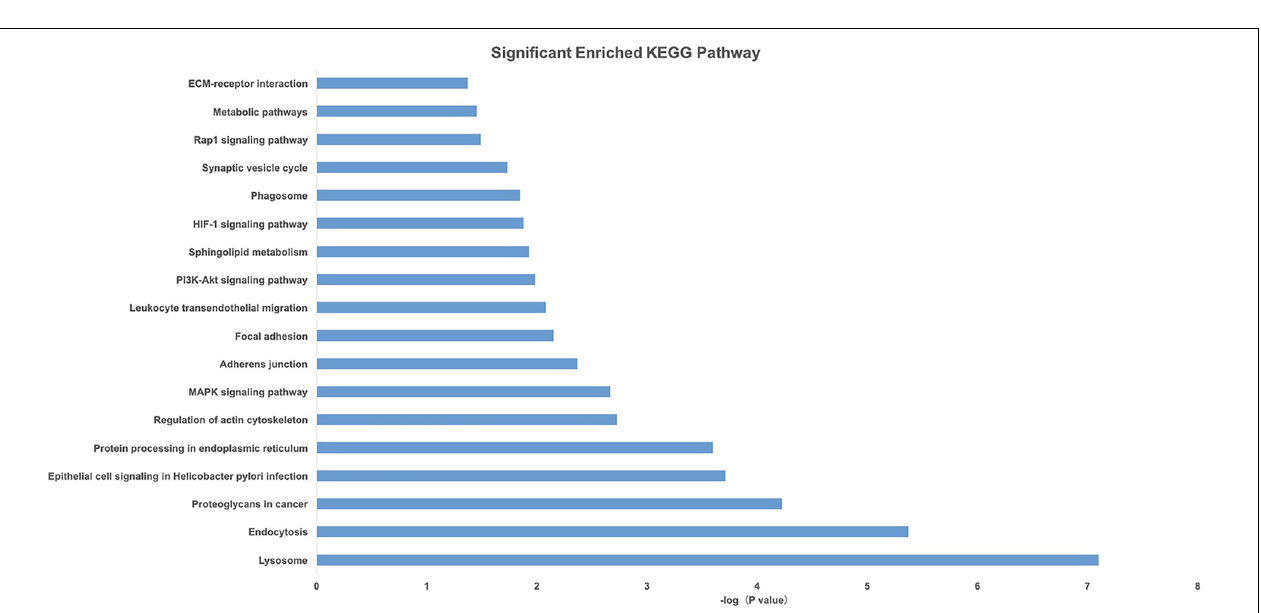
FIGURE 4 | Gene Ontology (GO) analysis of candidate genes. –Log10( p -value) of the corresponding biological process (BP), molecular function (MF), and cellular component (CC) (the top 15 GO annotations for each section). A larger –Log10 ( p -value) indicates a smaller p -value.